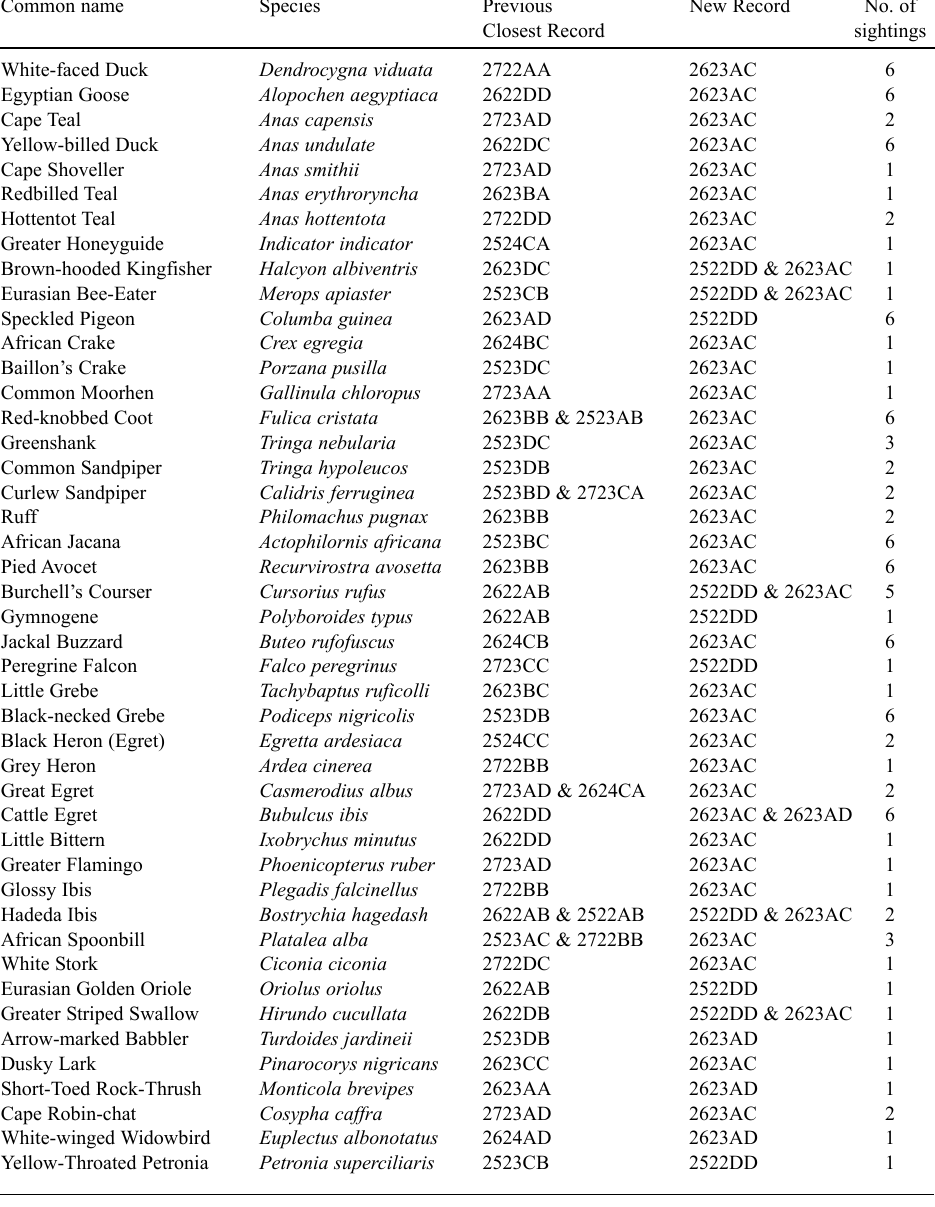
New records of bird species in the Bophirima District of the North-West Province, South